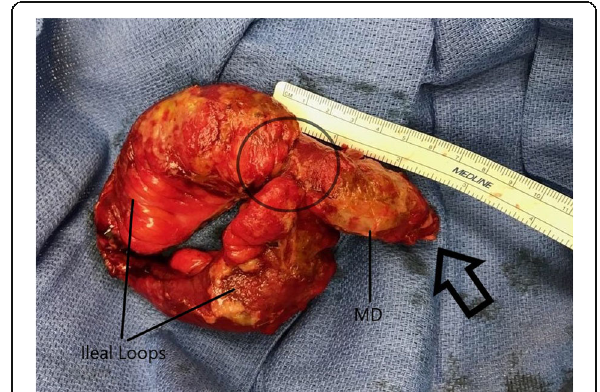
Fig. 1 Five centimeters of Meckel ’ s diverticula along a segment of ilium. Note the perforation at the apex (arrow) and narrow base (circle). Histology revealed evidence of pressure necrosis at the apex with perforation with no evidence of ectopic tissue or malignancy (data not